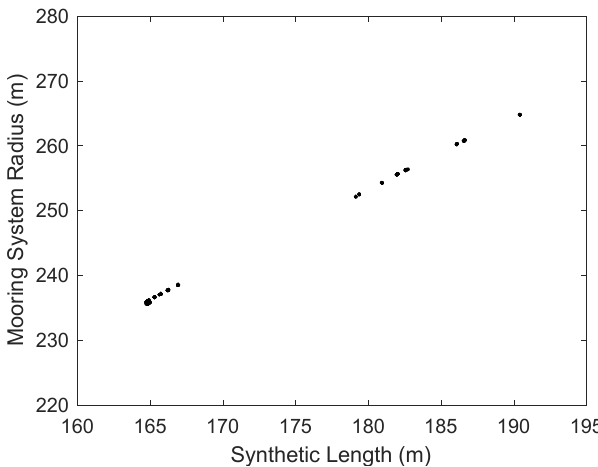
19 Figure 10. Designs along the Pareto-Optimal Front. The optimization performed started with 180 randomly generated individuals of which there were no restrictions on the initial seeding in the population. The constraint values were determined through the tiered-constraint method presented which was de- signed to both avoid running time domain simulations on infeasible designs, and to guide the optimizer towards feasible designs. This optimization was run several times with sim- ilar results observed including the jump in the Pareto front. In this optimization problem one of the objectives, mooring system component cost, is a function of chain diameter, synthetic length and synthetic diameter. To gain a better understanding of the relationship between mooring system radius with respect to these variables plots are provided for mooring system radius vs. synthetic line length, chain diameter and synthetic diameter in Figures 11–13, respectively.